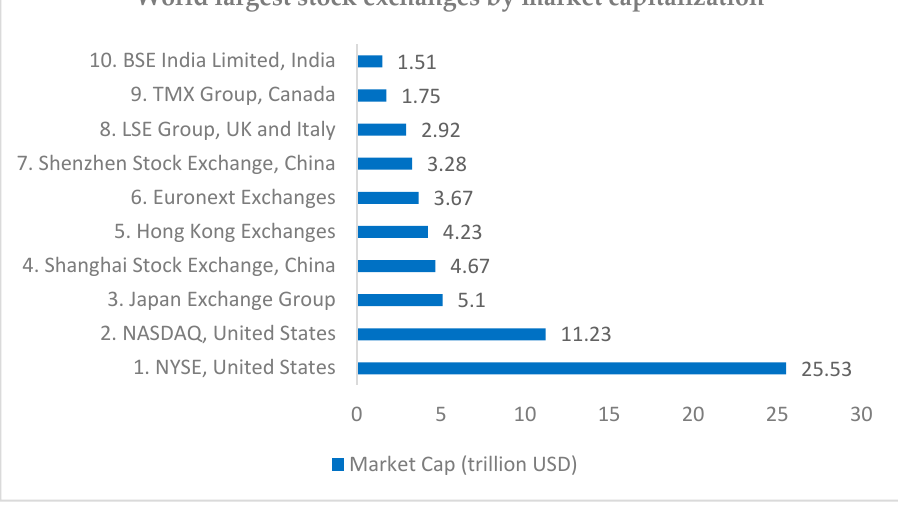
Figure 2. US monthly policy uncertainty index. Source: Baker, Bloom, and Davis [12].